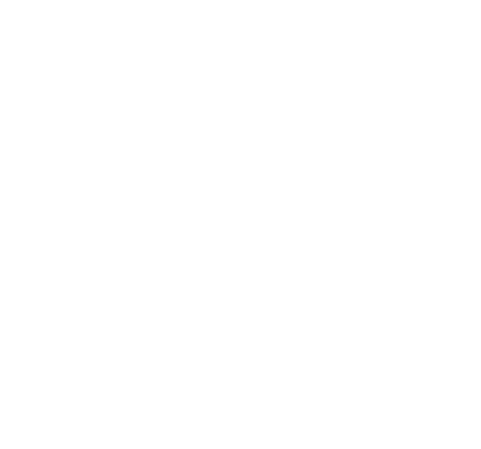
5 of 15 Figure 2. ( 1 ) Schematic for the fabrication process of the immunosensing interface. ( 2 ) Typical SWV signals of SA − Cu (a), SA − Pb (b), SA − Ti (c), and a mixture of these three hydrogels (d) ( A ). SWV characterizations of the modified procedure of electrodes ( B ) (reprinted with permission from Ref. [43], Copyright 2018, Elsevier). Besides, a multiplexed electrochemical immunosensing interface based on metal ions doped chitosan-poly(acrylic acid) nanospheres (CP) was proposed for the simultaneous detection of CEA, CA 19-9, CA 12-5, and CA 24-2 [62]. As depicted in Figure 3, with the crosslinking of glutaraldehyde (GA), four types of metal ions doped CP nanospheres were combined with different Ab 2 to synthesize the new immuoprobes, and chitosan-Au NPs were used as a common substrate to fix on the Ab 1 . Once sandwich conjugate was formed, four independent potential peaks were produced by copper(II), lead(II), cadmium(II), and zinc(II) ions when the whole system was readout with the Square wave voltammograms